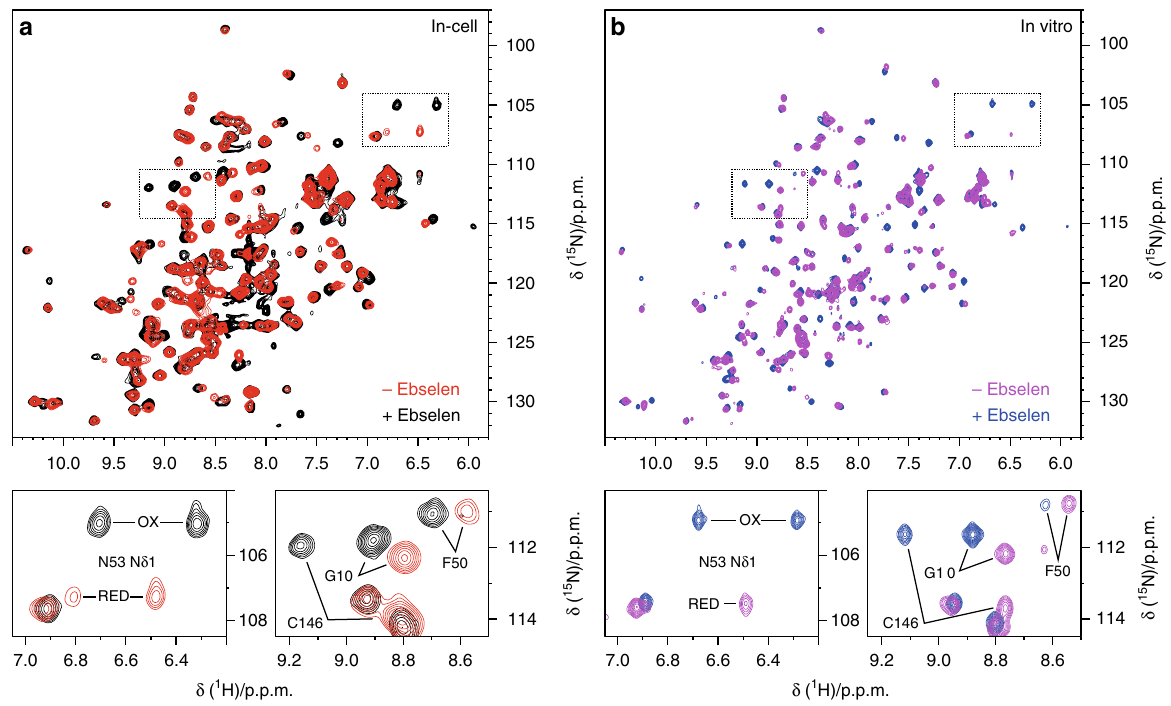
Fig. 4 Ebselen ef fi ciently oxidizes SOD1 in living cells. a Overlay of 1 H- 15 N NMR spectra acquired on human cells expressing [U- 15 N] labelled wild-type E, Zn-SOD1 in the absence (red) and in the presence (black) of ebselen in the external medium. b Overlay of 1 H- 15 N NMR spectra acquired on puri fi ed, disulphide-reduced [U- 15 N] labelled wild-type E,Zn-SOD1 before (blue) and after (magenta) treatment with 1 equivalent of ebselen. The positions of the enlarged areas (bottom panels) in the whole spectra (top panels) are indicated as dotted lines. Signals affected by the formation of the C57 – C146 disulphide bond are labelled in the bottom